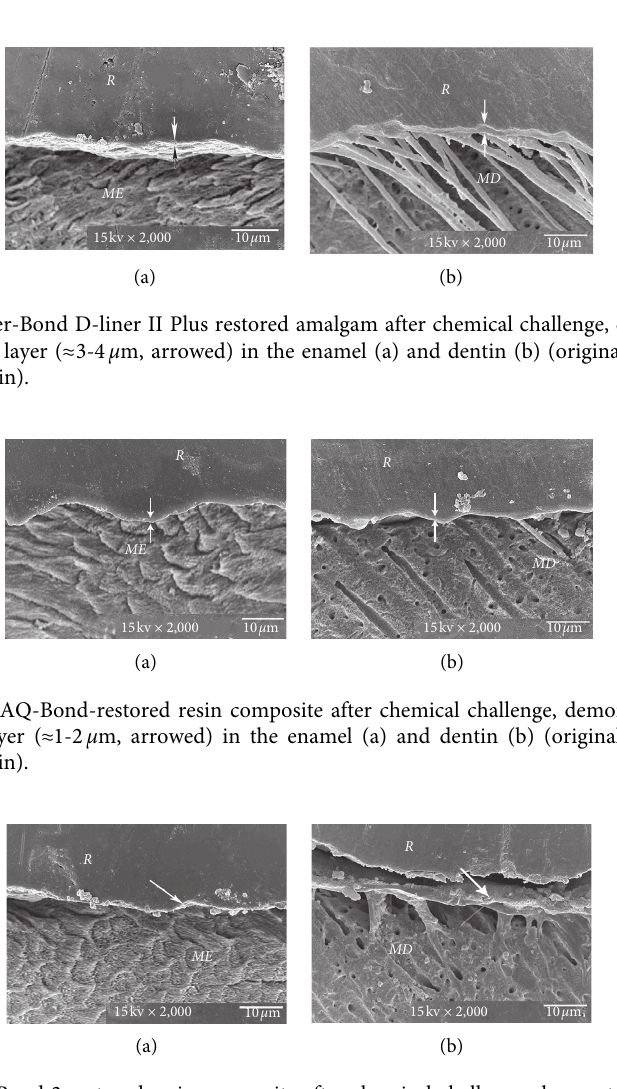
Figure 3: Dye penetration into leakage at the tooth-resin interface (arrowed) after artificial caries exposure: (a) All-Bond 2, (b) Clearfil Protect Bond, and (c) non-adhesive amalgam, a positive control (original × 50, E � enamel, A � amalgam, D � dentin, R � resin-composite, and a white line � dye penetration into the adjacent cementum/dentin).